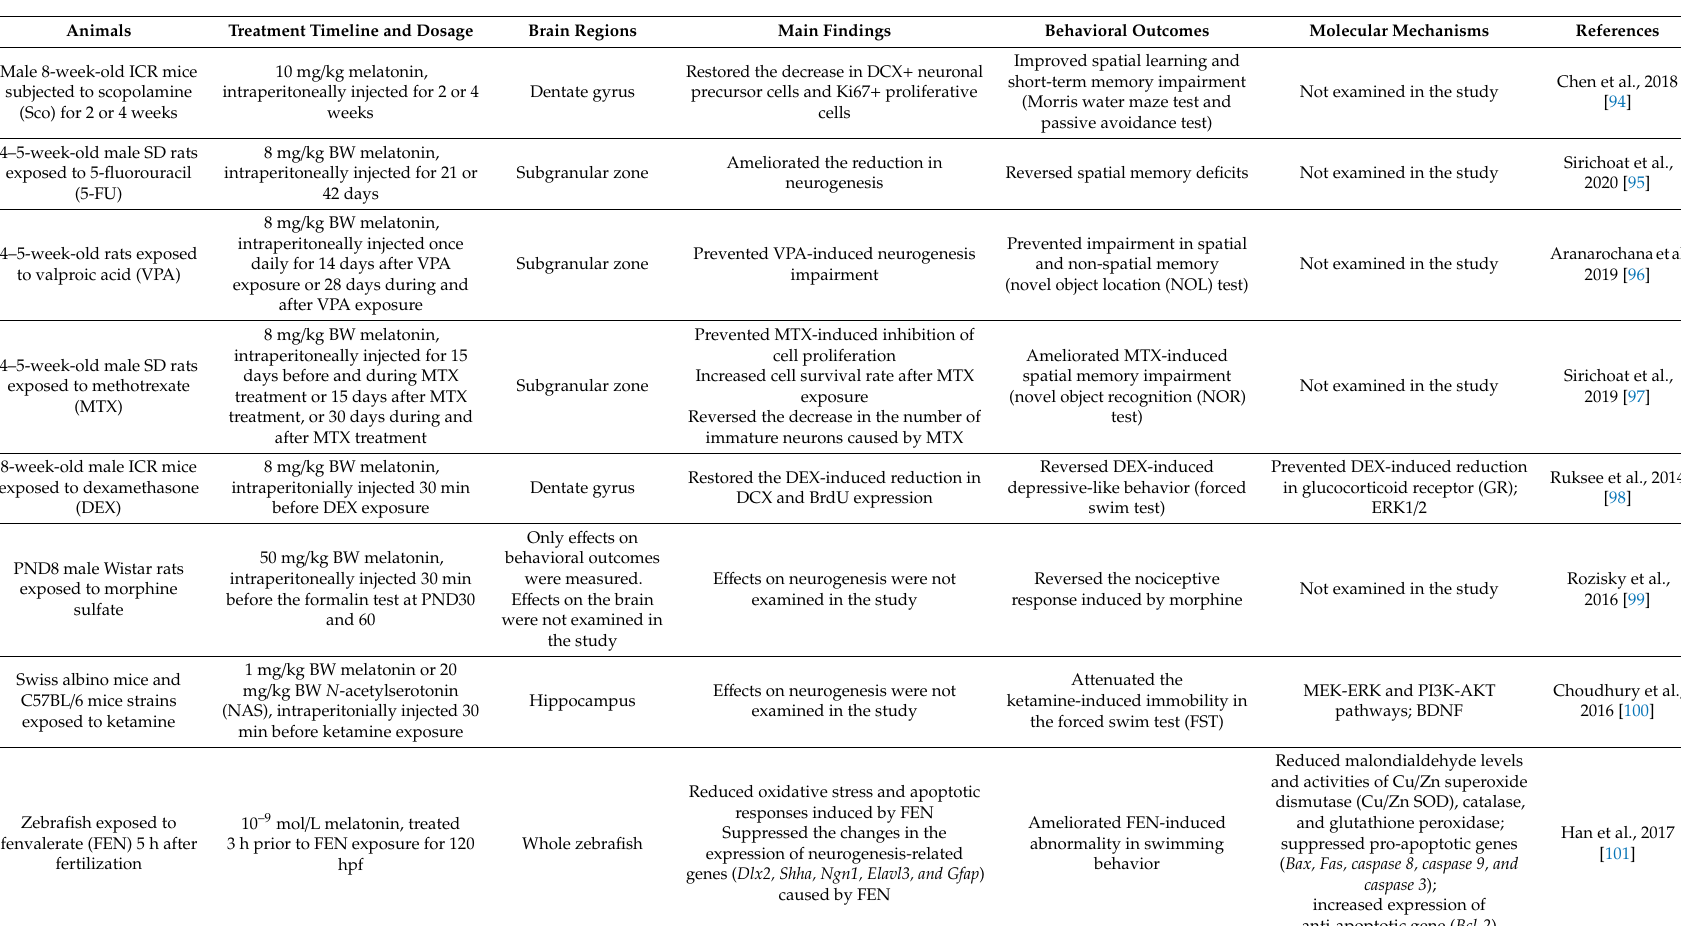
Table 10. Table showing the main findings regarding the e ff ects of melatonin or its precursor and metabolite on neurogenesis impairment caused by environmental factors and the respective molecular mechanisms in the in vivo